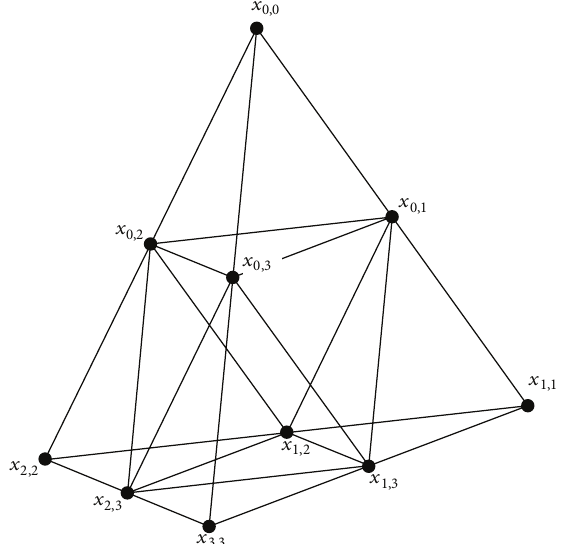
Figure5:Thegraphdeterminedby 𝐹 0,1 inagraph Γ 𝑚 ,approximating P 5 .